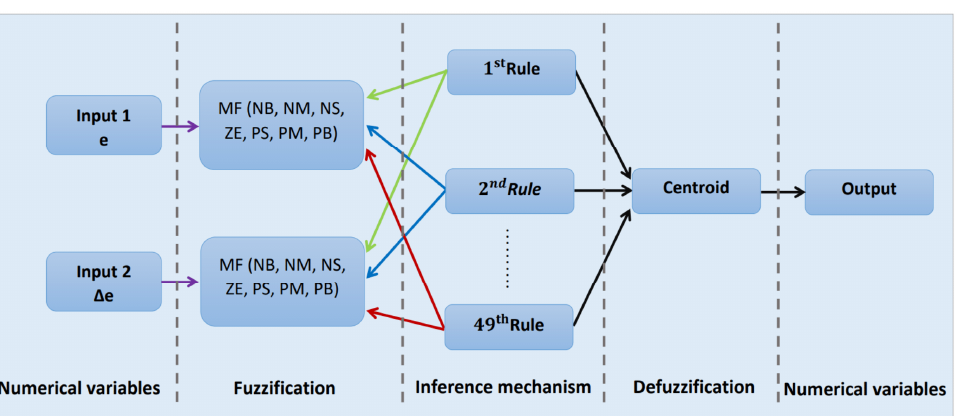
Figure 8. Fuzzy logic controller block diagram.